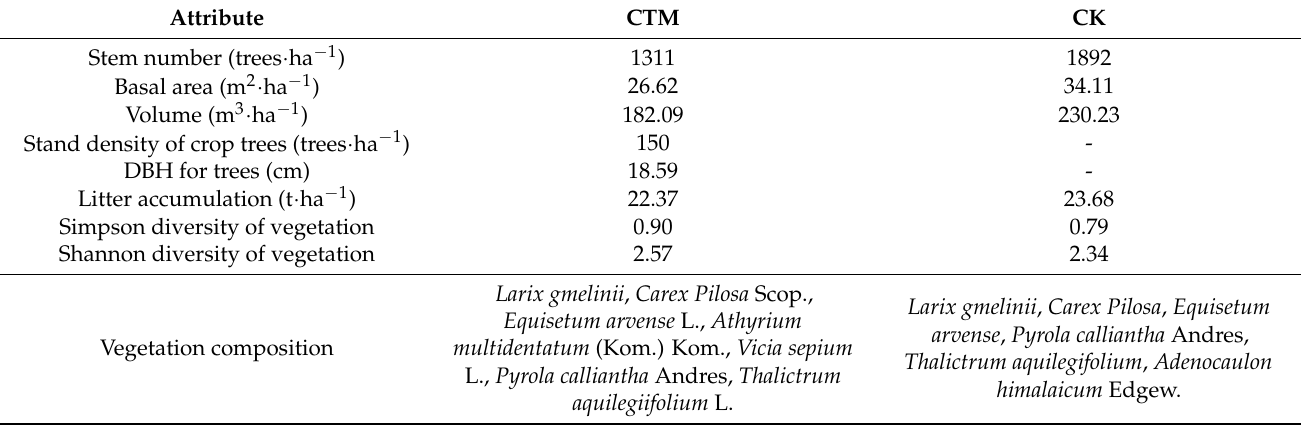
Table 1. Basic information of L. gmelinii plantation after five years of crop trees